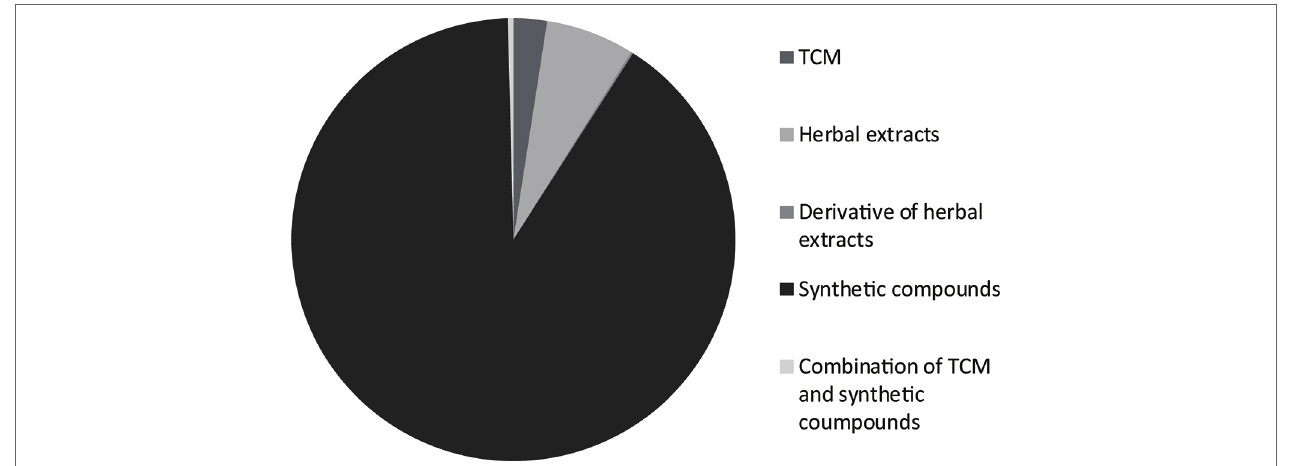
FIGURE 3 | Distribution and composition of traditional Chinese medicine (TCM), herbal extracts, derivatives of herbal extracts, synthetic compounds and combinations of synthetic compounds and TCM patents for anti-T2DM therapies issued in